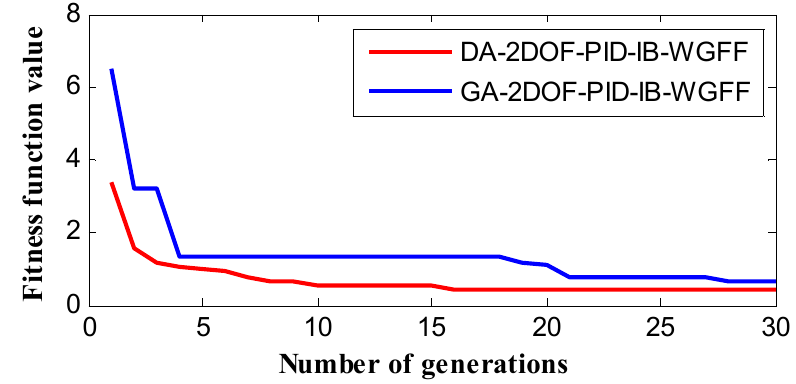
Figure 27. Comparative graph for the fitness function value using ITAE.